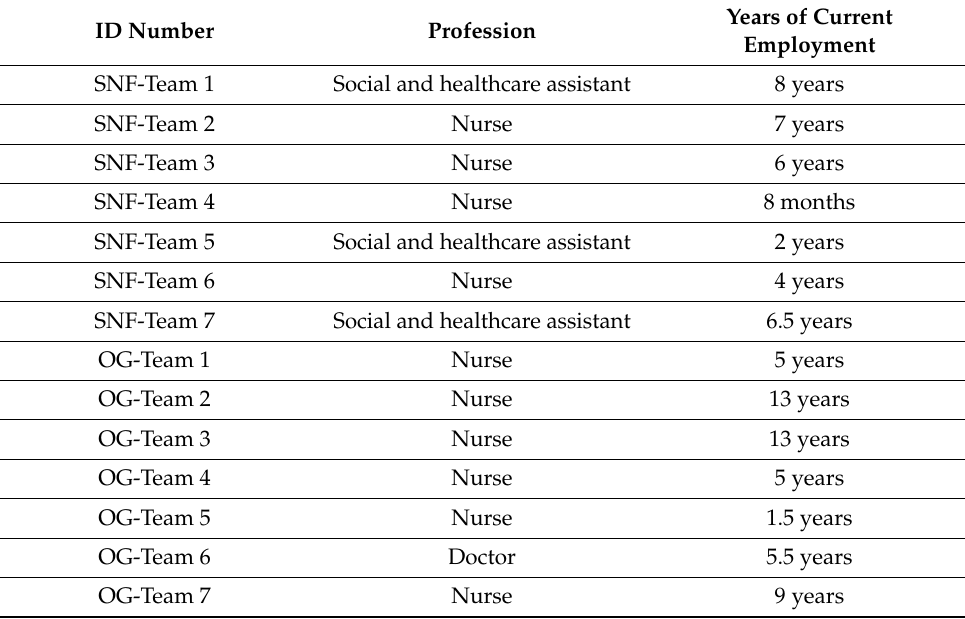
Table 1. Participants from the two teams, their profession, and length of employment. ID